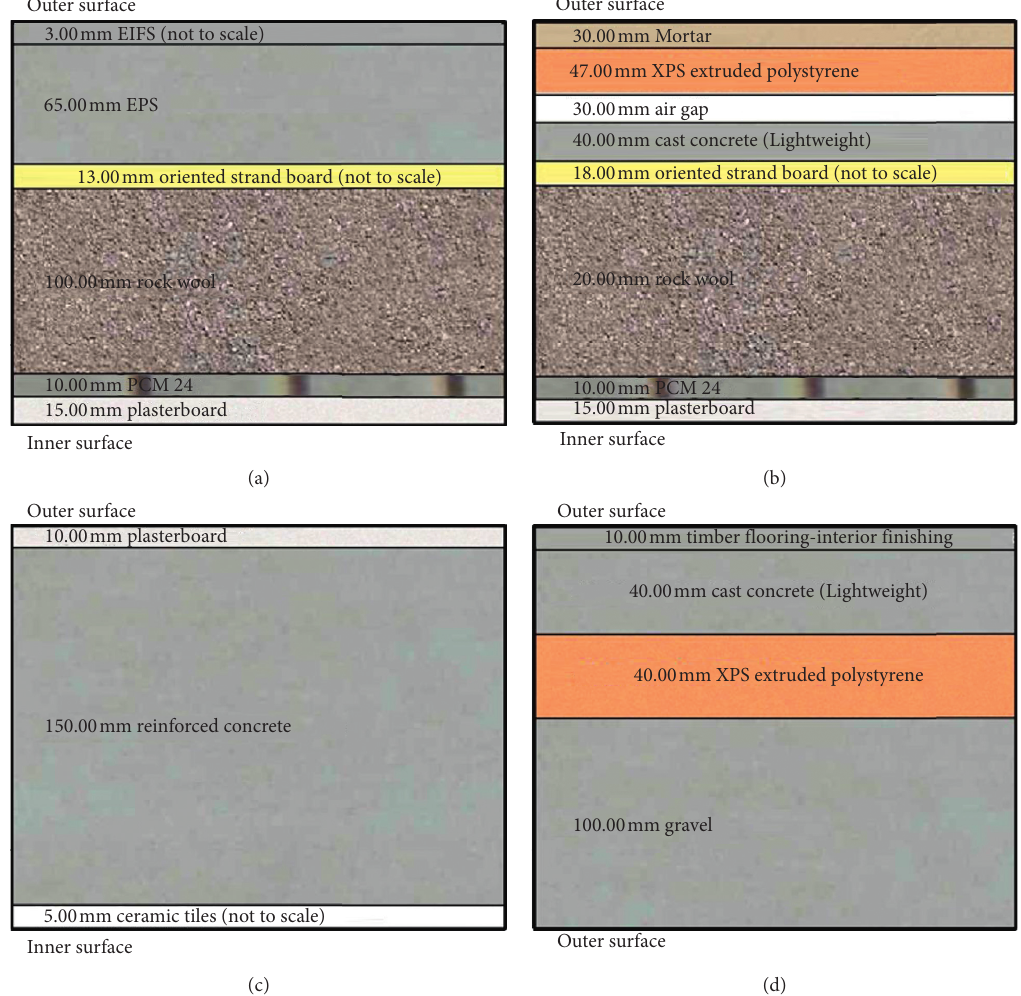
Figure 4: Detailed illustrations of wall, roof, and floors composition. (a) Wall composition. (b) Roof composition. (c) Intermediate floor (d)